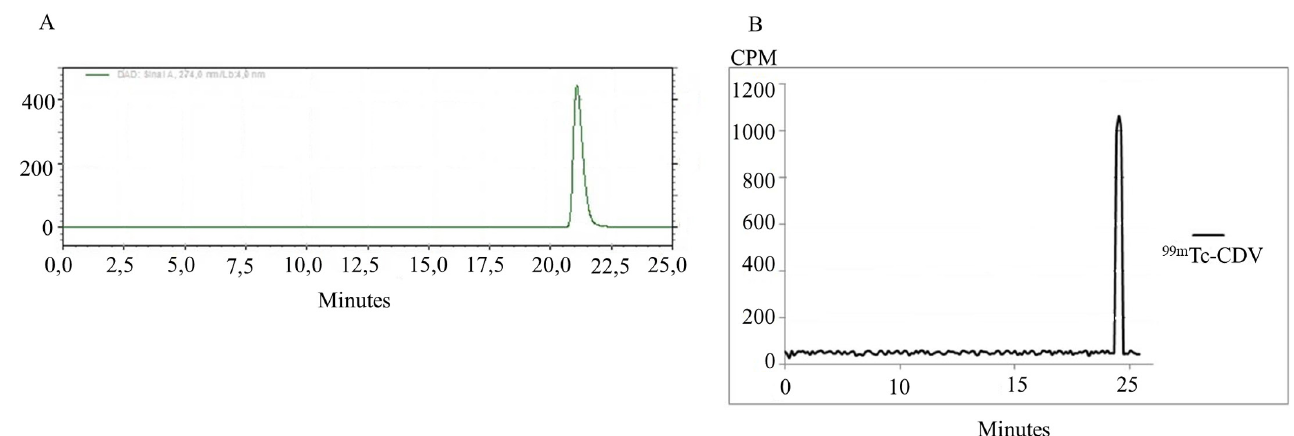
FIGURE 2 - Reverse phase HPLC chromatogram (a) and radiochromatogram (b) of 99m Tc-CDV.